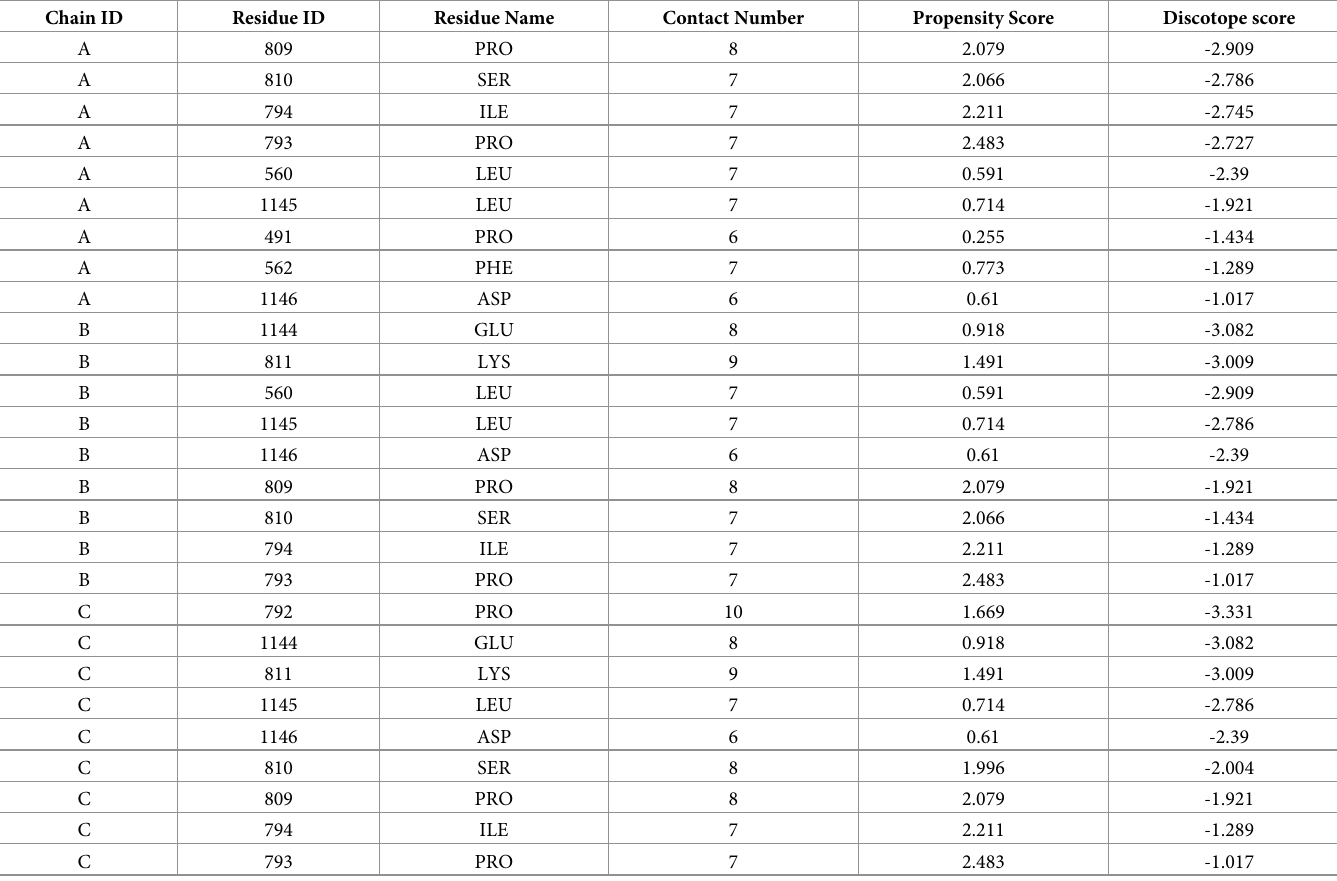
Table 2. Discontinuous B cell epitope contact numbers in the spike glycoprotein. Chain